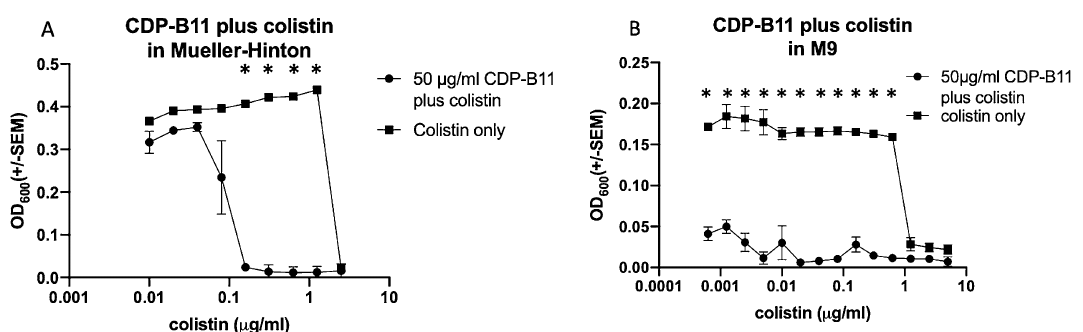
Figure 3. Optical density (600 nm) after 20 h culture for E. coli AR #0346 with both CDP-B11 and colistin in ( A ) Mueller–Hinton media, or ( B ) M9 media. Circles represent colistin concentration with a fixed concentration (50 μg/mL) of CDP-B11. Squares represent cultures treated with colistin only. Statistical comparisons were performed with the corresponding Holm–Sidak method and α ≤ 0.05, without assuming equal